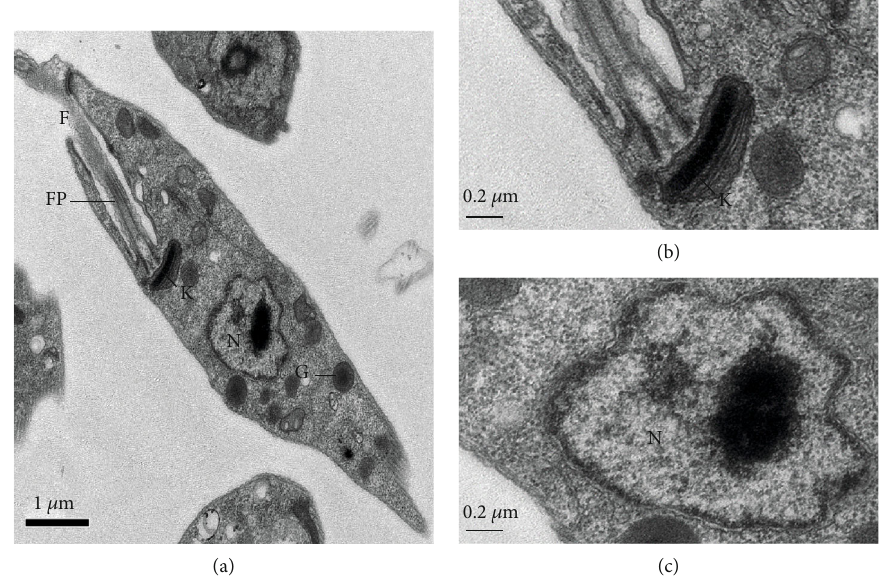
Figure 2: Ultrastructure of promastigote forms of L. ( L. ) infantum : (a) general morphology of L. ( L. ) infantum promastigote ( × 25K); (b) detail of fl agellar pocket (FP) and kinetoplast (K) of control untreated ( × 80K); glycosome (G); (c) nucleus (N), membrane, and chromatin without changes in untreated control ( ×